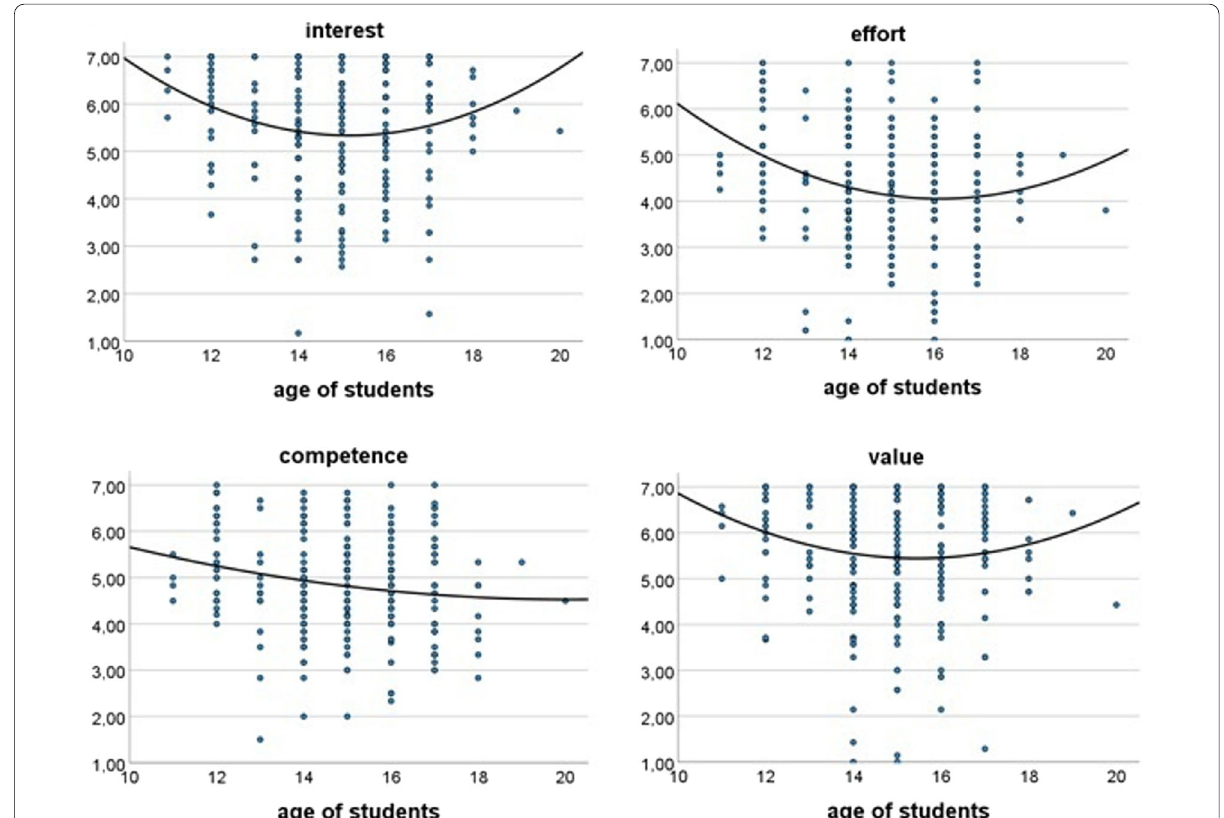
Fig. 5 Fitted line plot of the quadratic model for the relationship between student age and interest, effort, competence or